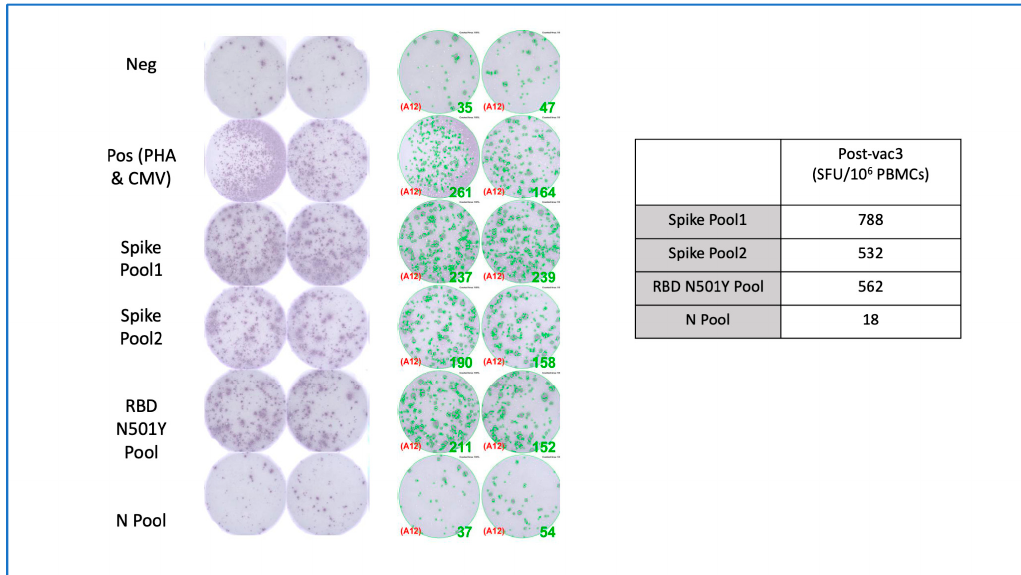
Figure 2. SARS-CoV-2-specific T cells were detected using interferon-gamma ELISpot assay after the intradermal ChAdOx1. The figure showed scanned images and SFU/well counts for unstimulated and stimulated PBMCs. The final SFU per one million PBMCs after subtracting the background was summarized in a table. ELISpot, enzyme-linked Immunospot; Neg, negative; Pos, positive; PHA, phytohemagglutinin; CMV, cytomegalovirus; RBD, receptor-binding domain; SFU, spot-forming unit; PBMCs, peripheral blood mononuclear